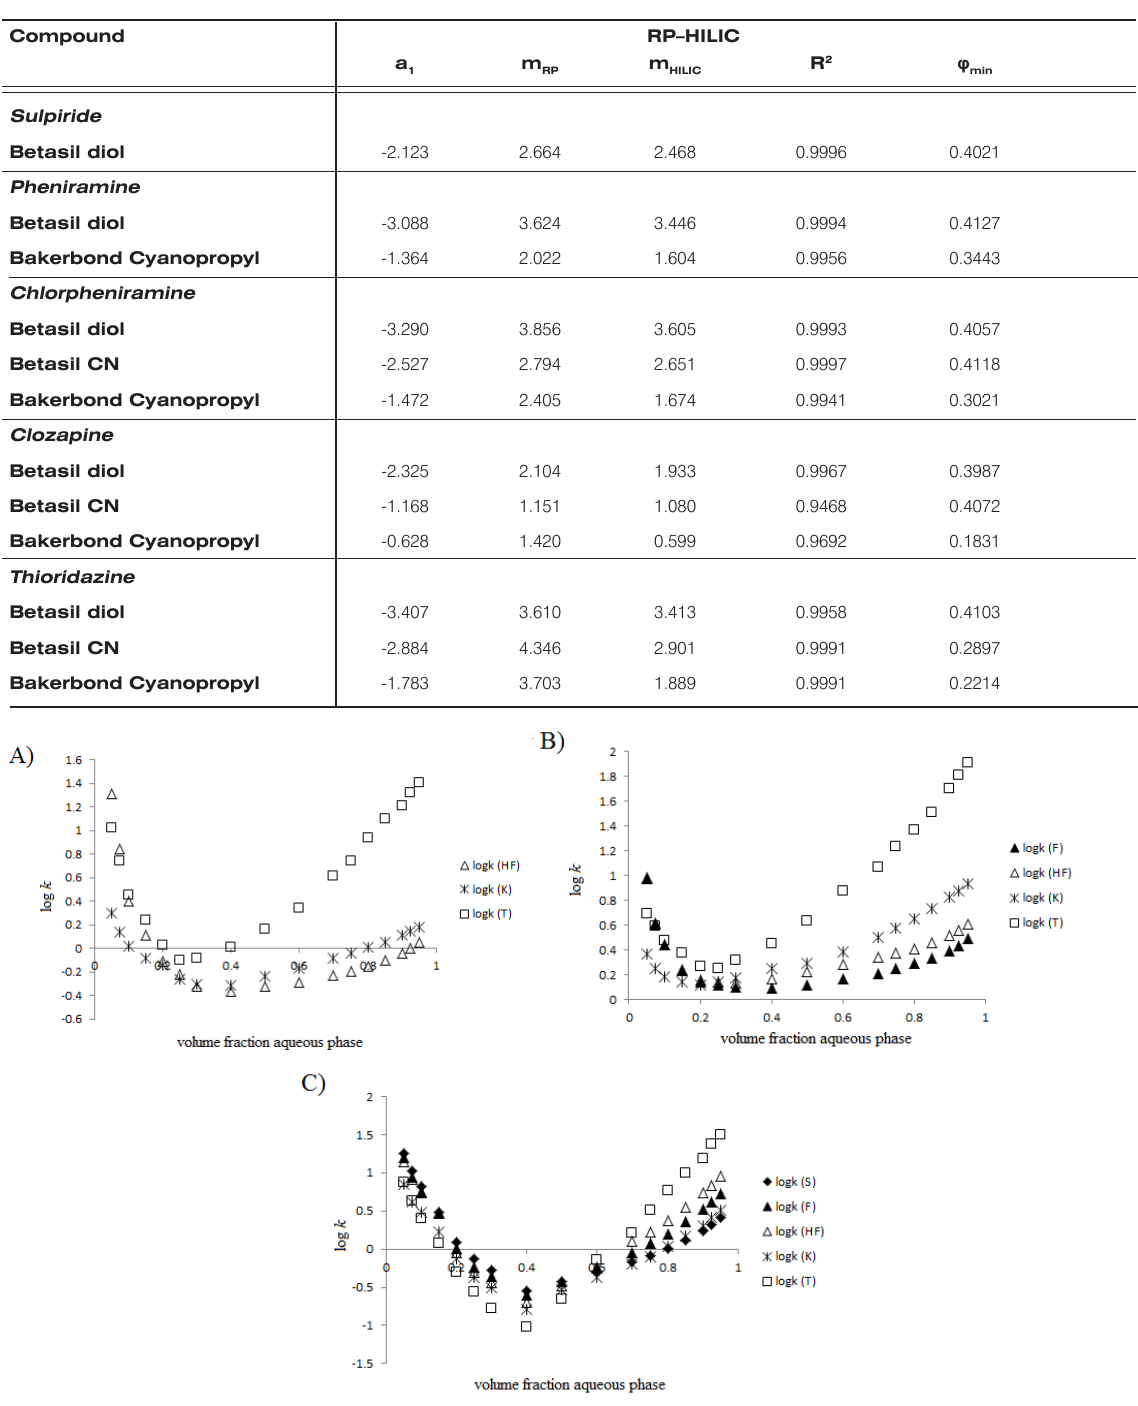
Figure 3. RP–HILIC data represented in log k vs . volume fraction of the aqueous phase plots in broad range of mobile phase compositions (5–95 %) on A) Betasil CN column, B) Bakerbond Cyanopropyl column and C) Betasil diol column. Solute identities: diamonds–sulpiride (S), full triangles–pheniramine (F), empty triangles–chlorpheniramine (HF), stars–clozapine (K), empty squares–thioridazine (T). Mobile phase: ACN–water in the range from (95:5 v/v) to (5:95 v/v) containing 20 mmol L -1 ammonium acetate pH 3.5. For other conditions see Fig.